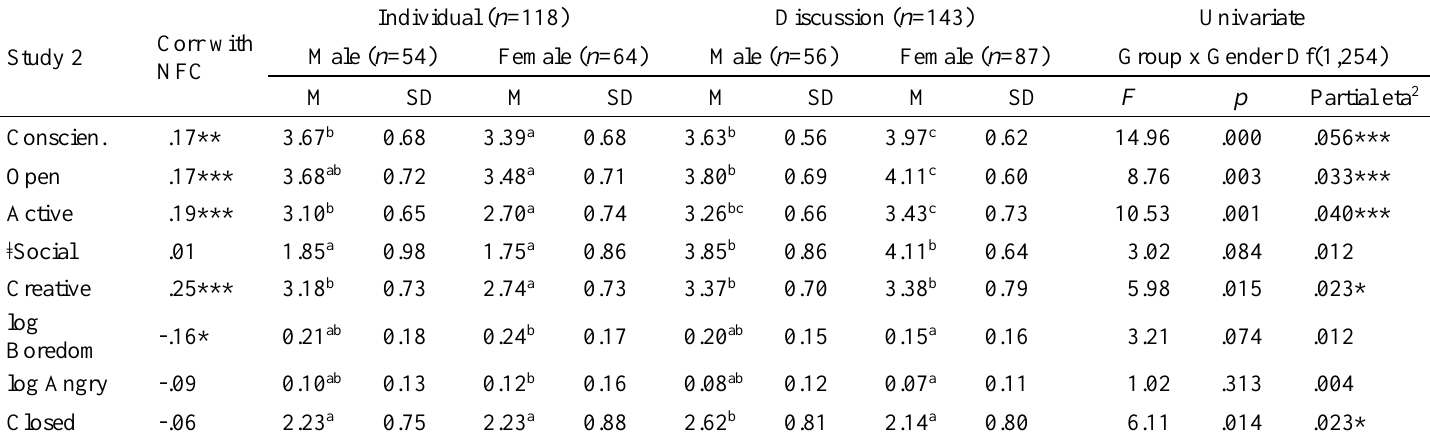
Study 2 effects of NFC, group discussion, and gender on engagement states during T3 deliberation Corr with Study 2